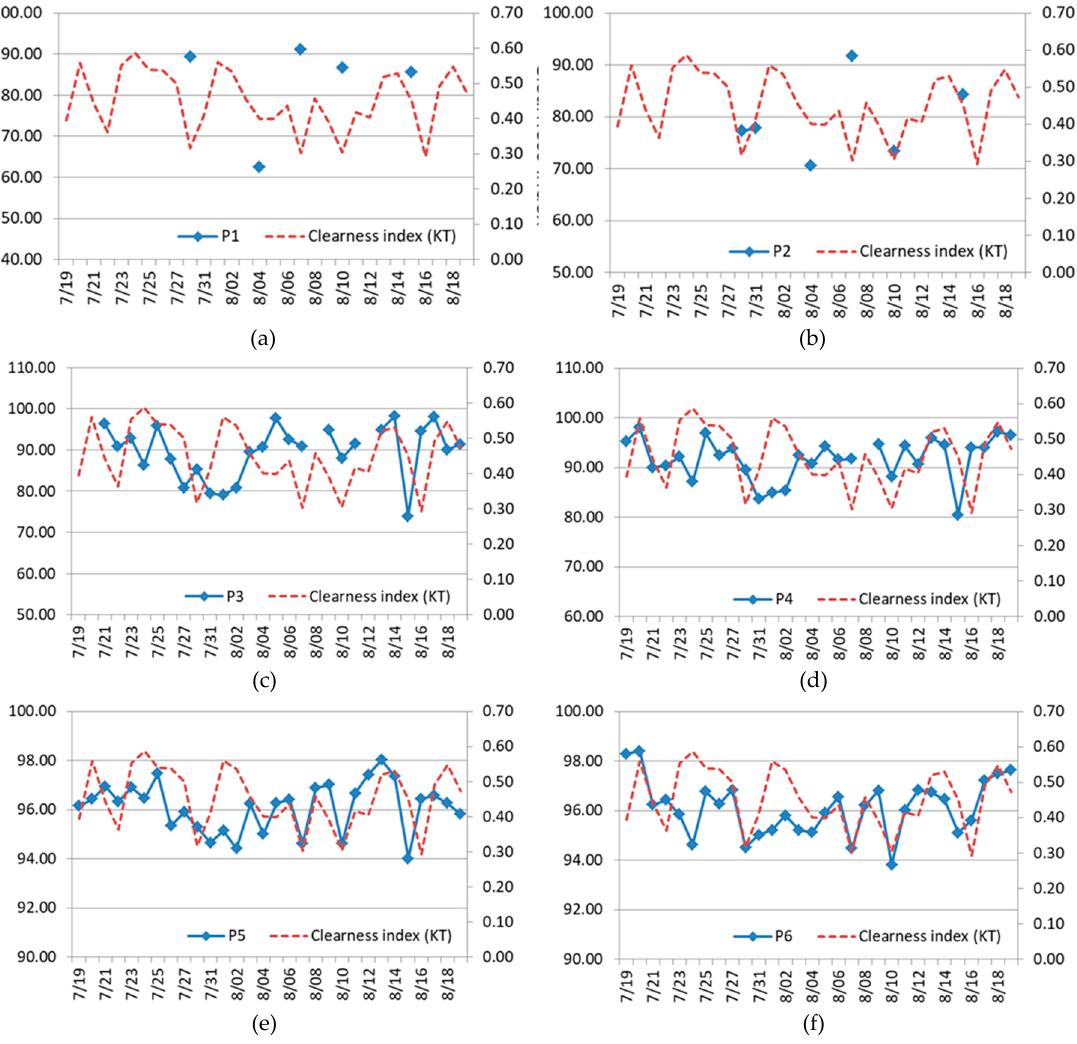
Figure 19. Daily average daylight illuminance on the workplane prediction accuracy and daily clearness index for points ( a ) P1, ( b ) P2, ( c ) P3, ( d ) P4, ( e ) P5, and ( f ) P6.